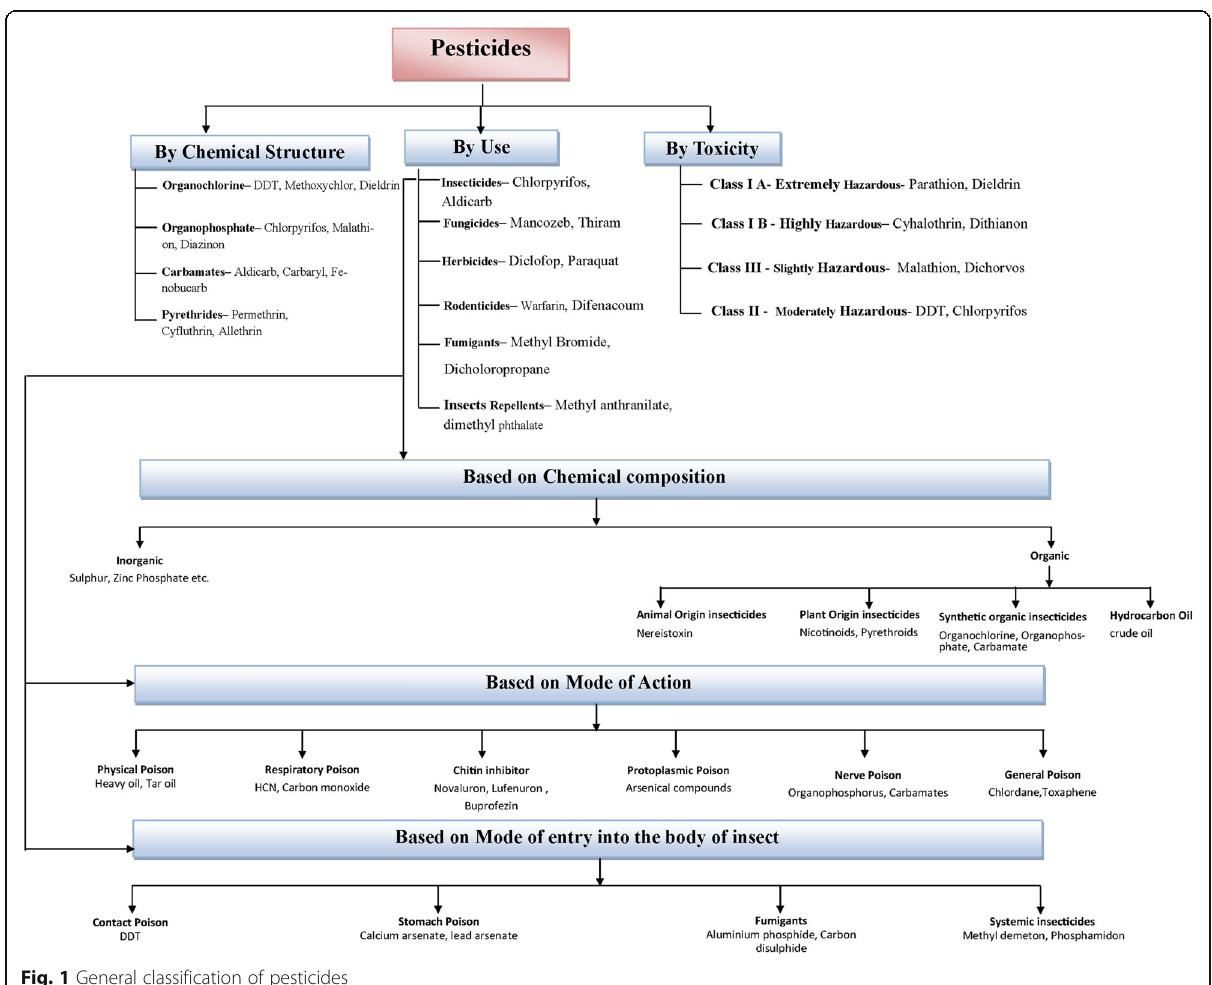
Fig. 1 General classification of